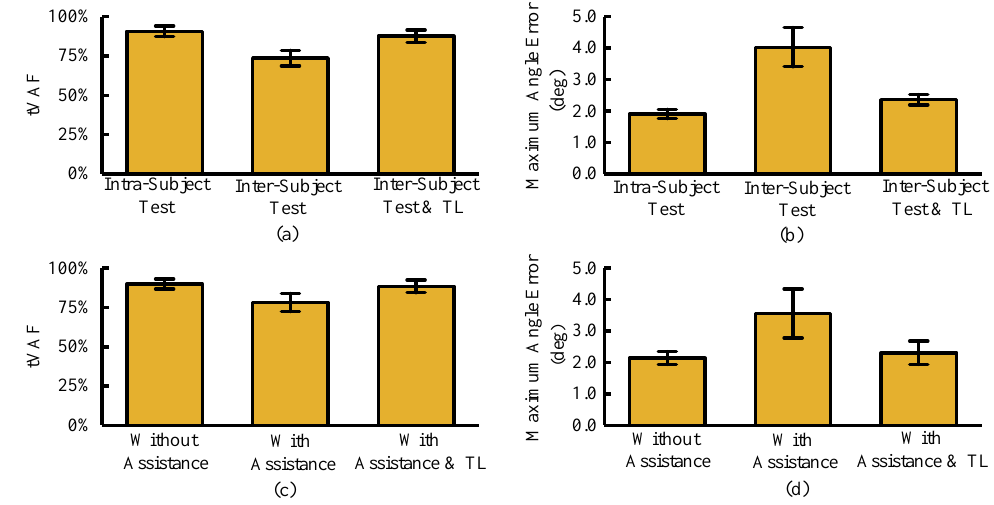
Figure 12. The result adaptation of feature extraction and motion prediction network with and with- out exoskeleton. ( a ) The adaptation results of CAE; ( b ) The adaptation results of motion prediction; ( c ) The adaptation results of CAE with exoskeleton; ( d ) The adaptation results of motion prediction with exoskeleton. ‘Inter-subject test & TL’ means the feature extraction and prediction network are trained using data of group A and tested using the data from group B. Meanwhile, the partial parameters of feature extraction and prediction network are online tuned by the adaptation